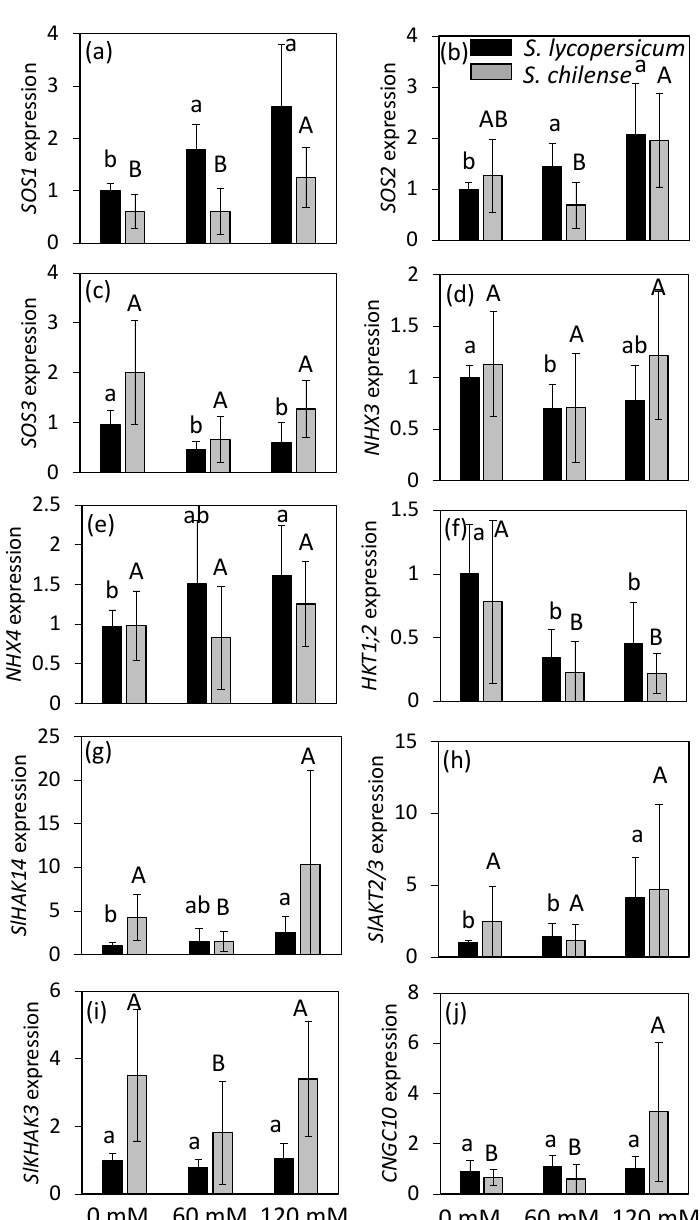
Figure 5. Expression of 10 genes involved in minerals transport analyzed by qRT-PCR on flowers of Solanum lycopersicum and Solanum chilense growing at 0, 60, and 120 mM NaCl. ( a ) SOS1 (Salt Overly Sensitive 1, Solyc01g005020); ( b ) SOS2 (Salt Overly Sensitive 2, Solyc12g009570); ( c ) SOS3 (Salt Overly Sensitive 3, Solyc06g051970); ( d ) NHX3 (vacuolar Na + /H + antiporter 3, Solyc01g067710); ( e ) NHX4 (vacuolar Na + /H + antiporter 4, Solyc01g098190); ( f ) HKT1;2 (class I—High affinity K + transporter 2, Solyc07g014680); ( g ) SlHAK14 (High Affinity K + transporter 14, Solyc09g074820); ( h ) SlAKT2/3 (inward-rectifying K + channel, Solyc10g024360); ( i ) SlHAK3 (High Affinity K + transporter 3, Solyc12g096580); ( j ) CNGC10 (Cyclic Nucleotide Gated Channel 10, Solyc05g050350). The tomato elongation factor gene ( LeEF-1 α , Solyc06g005060) and TIP41-like protein ( TIP41 , Solyc10g04985) were used as the reference genes. Expressions are given based on S. lycopersicum grown at 0 mM NaCl, to which a value of 1 was assigned. Data are means ± SD, treatments followed by different letters are significantly different at p < 0.05 for the same species (lowercase, S. lycopersicum , uppercase, S. chilense ).